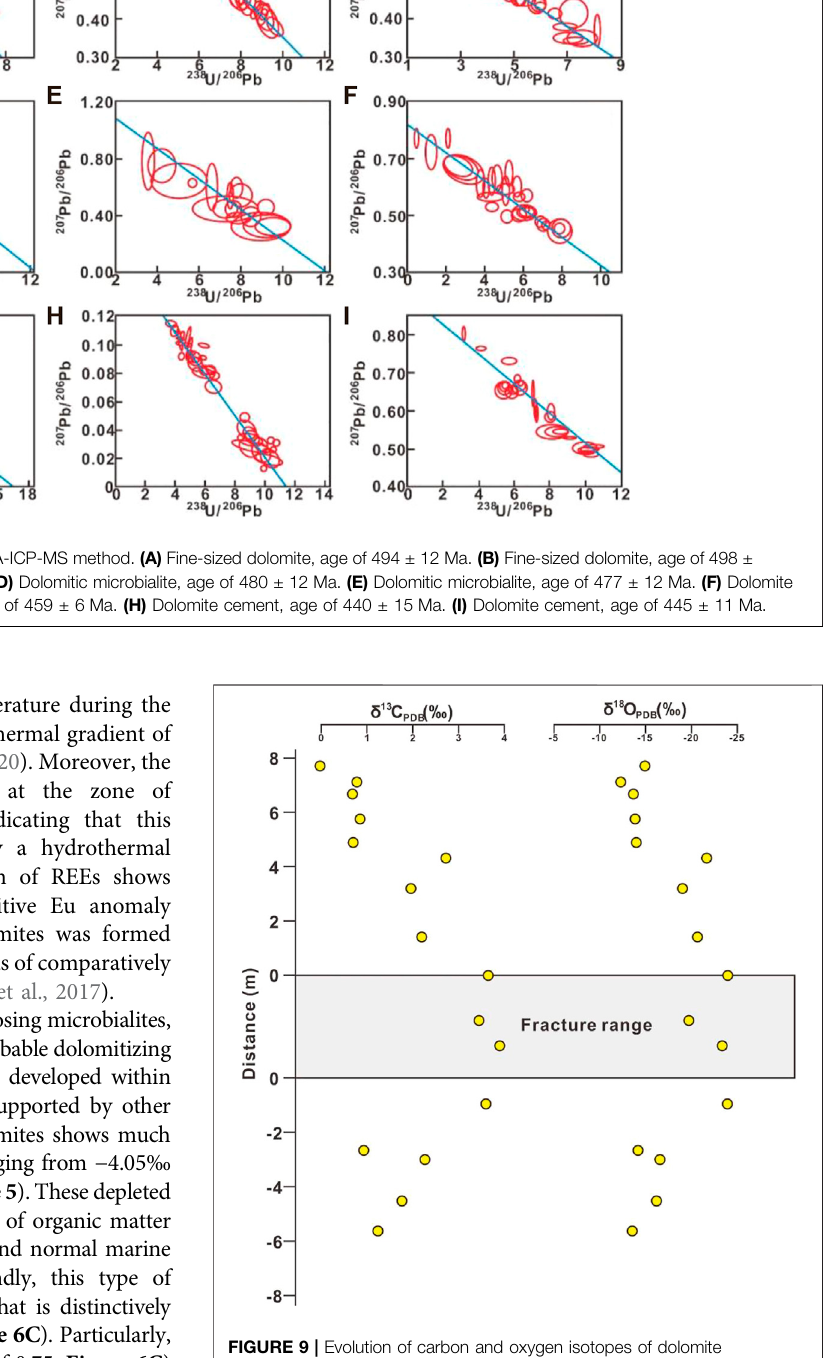
Frontiers in Earth Science |